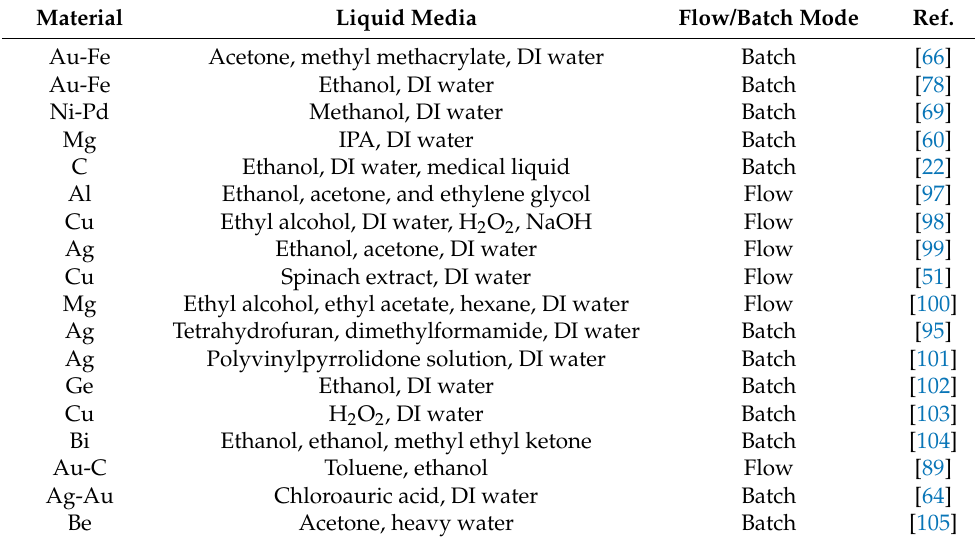
Table 2. Publications reporting the investigation of 2 or more liquid media during the pulsed laser ablation in liquid